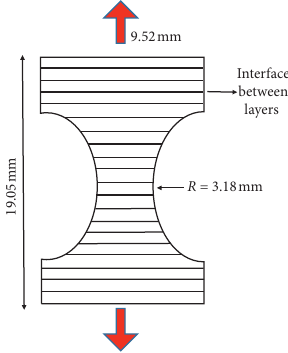
Figure 13: Illustration of tensile loading with respect to the in- terface (redrawn from